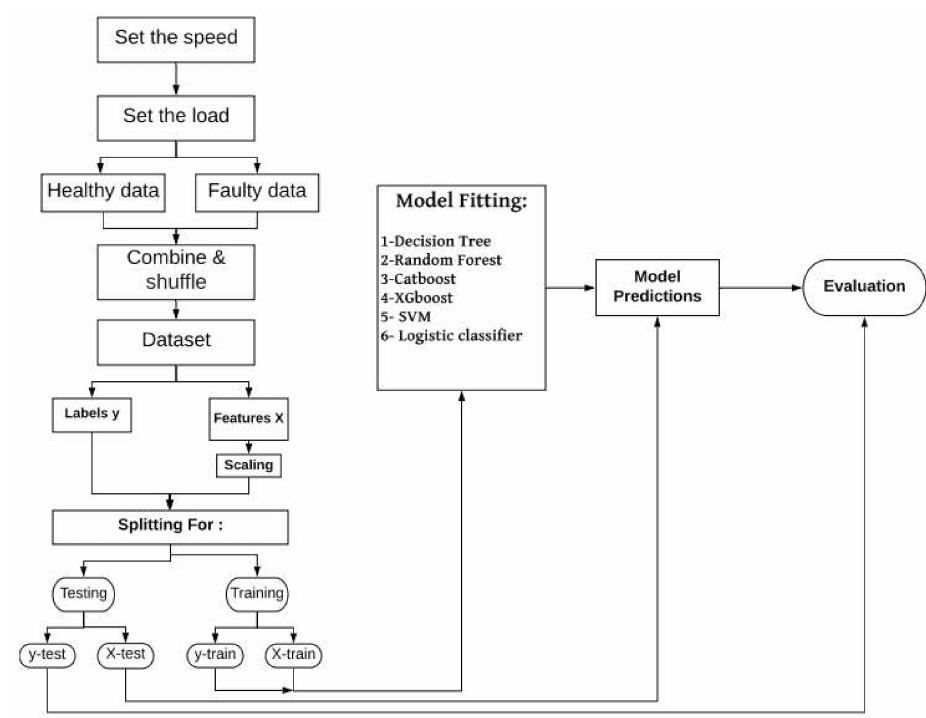
Figure 5. Simplified modelling process